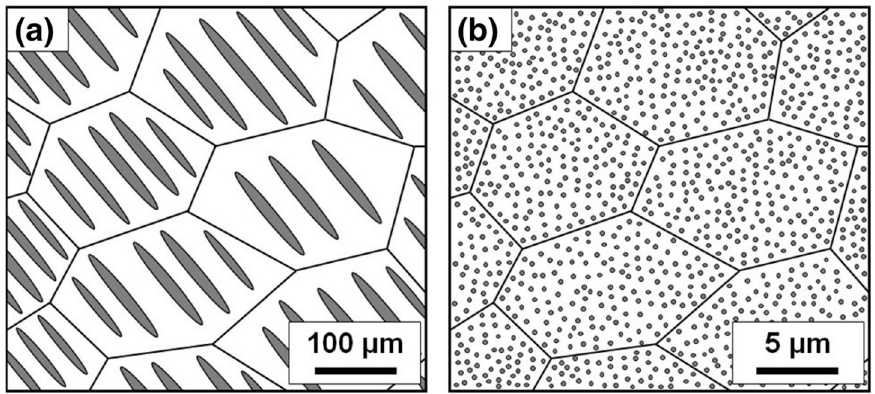
Figure 6. Schematics comparing micro- and nanocomposites synthesized by ( a ) arc melting (normal cooling rate) and ( b ) MS (high cooling rate). Reproduced with permission from Ref. [34]. Copyright 2016, Springer Nature.